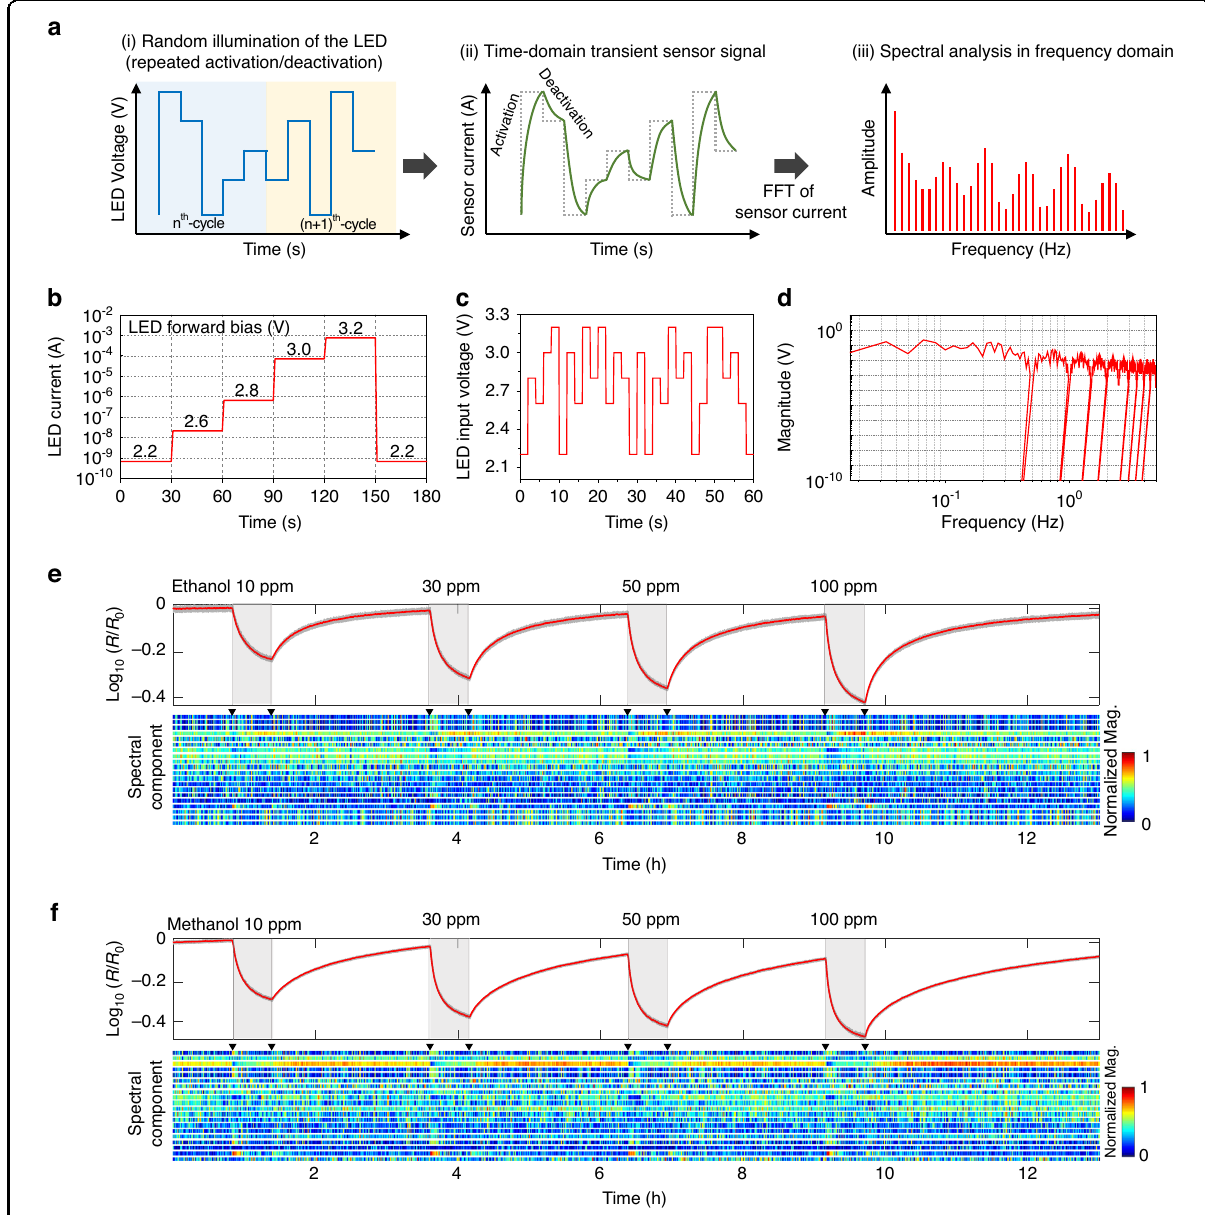
Fig. 2 Investigation of pseudorandom operation. a Schematic of the operation strategy of the micro-LED ( μ LED)-embedded photoactivated gas sensor. a -(i) shows a pseudorandom input to μ LED consisting of shuf fl ed fi ve levels of voltages. a -(ii) shows the time-domain transient sensor signal (sensor current). Alternation of photoactivation and deactivation causes the difference in the transient signals to different gas species. a -(iii) shows the frequency spectrum of the normalized sensor signal. b Measured forward current of μ LED with fi ve selected levels of μ LED voltages. c Pseudorandom input consisting of fi ve selected levels of voltages (time interval = 2 s and sampling rate = 10 Hz) in a unit time window (60 s). d Frequency spectrum of pseudorandom input in a time window. e , f Dynamic response (Log 10 ( R / R 0 )) and spectrogram of the sensor signal to ethanol and methanol with various concentrations. Gray and red lines indicate raw transient signals and moving averages in a 60 s time window, respectively. The highly ranked 46 spectral components were used for the spectrogram data, but only 20 components are shown in the fi